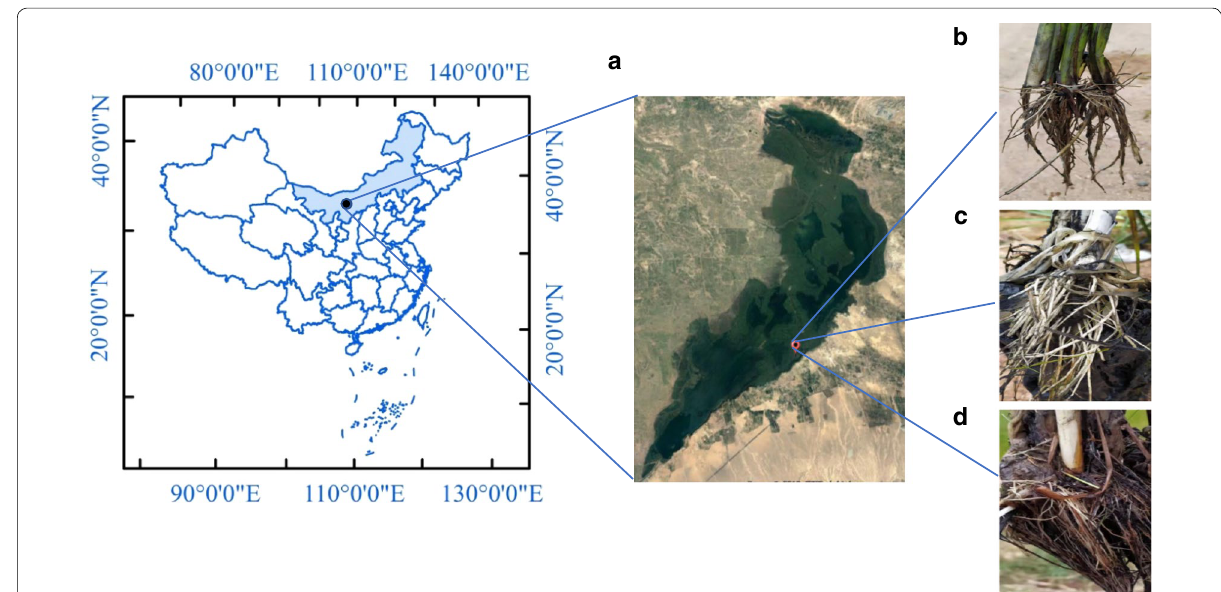
Fig. 1 Sampling site ( a ) of P. australis ( b ), T. angustifolia ( c ) and S. triqueter ( d ) in the natural wetland of